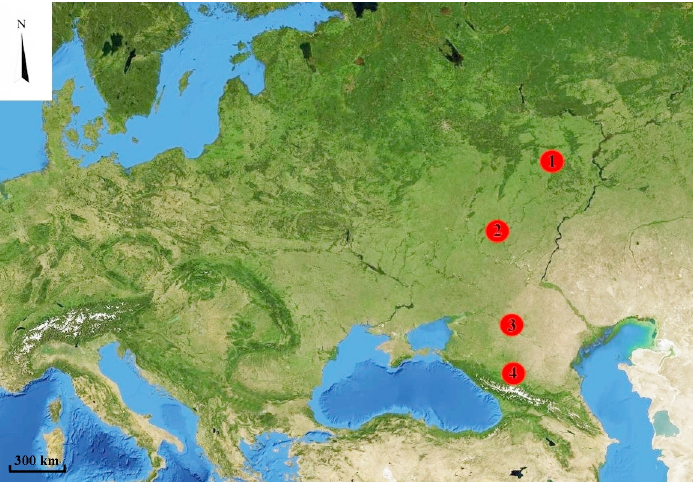
Figure 1. Study area. Regions where material was collected are indicated by numbers: 1—Republic of Mordovia (central point 54.132743 N, 45.125624 E); 2—Voronezh region (50.979972 N, 41.214608 E); 3—Rostov region (46.637851 N. 42.443879 E); 4—Stavropol region (43.836050 N, 42.683688 E). Studies were conducted near the village of Yalga and the city of Saransk (Mordovia), near the village Yellow Ponds (Novokhopersk district, Voronezh region), in the vicinity of the village Proletarsky (Orlovsky district, Rostov region),and 7 km south of the city of Kislovodsk (Predgorny municipal district, Stavropol region, 43.905518 N, 42.715718 E).